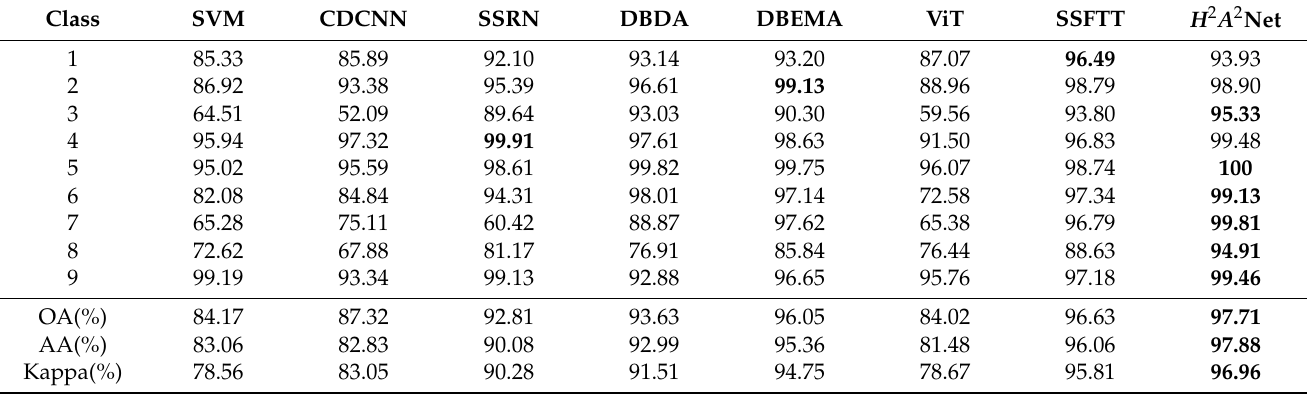
Table 5. The classification accuracy for the UP dataset based on 0.5% training